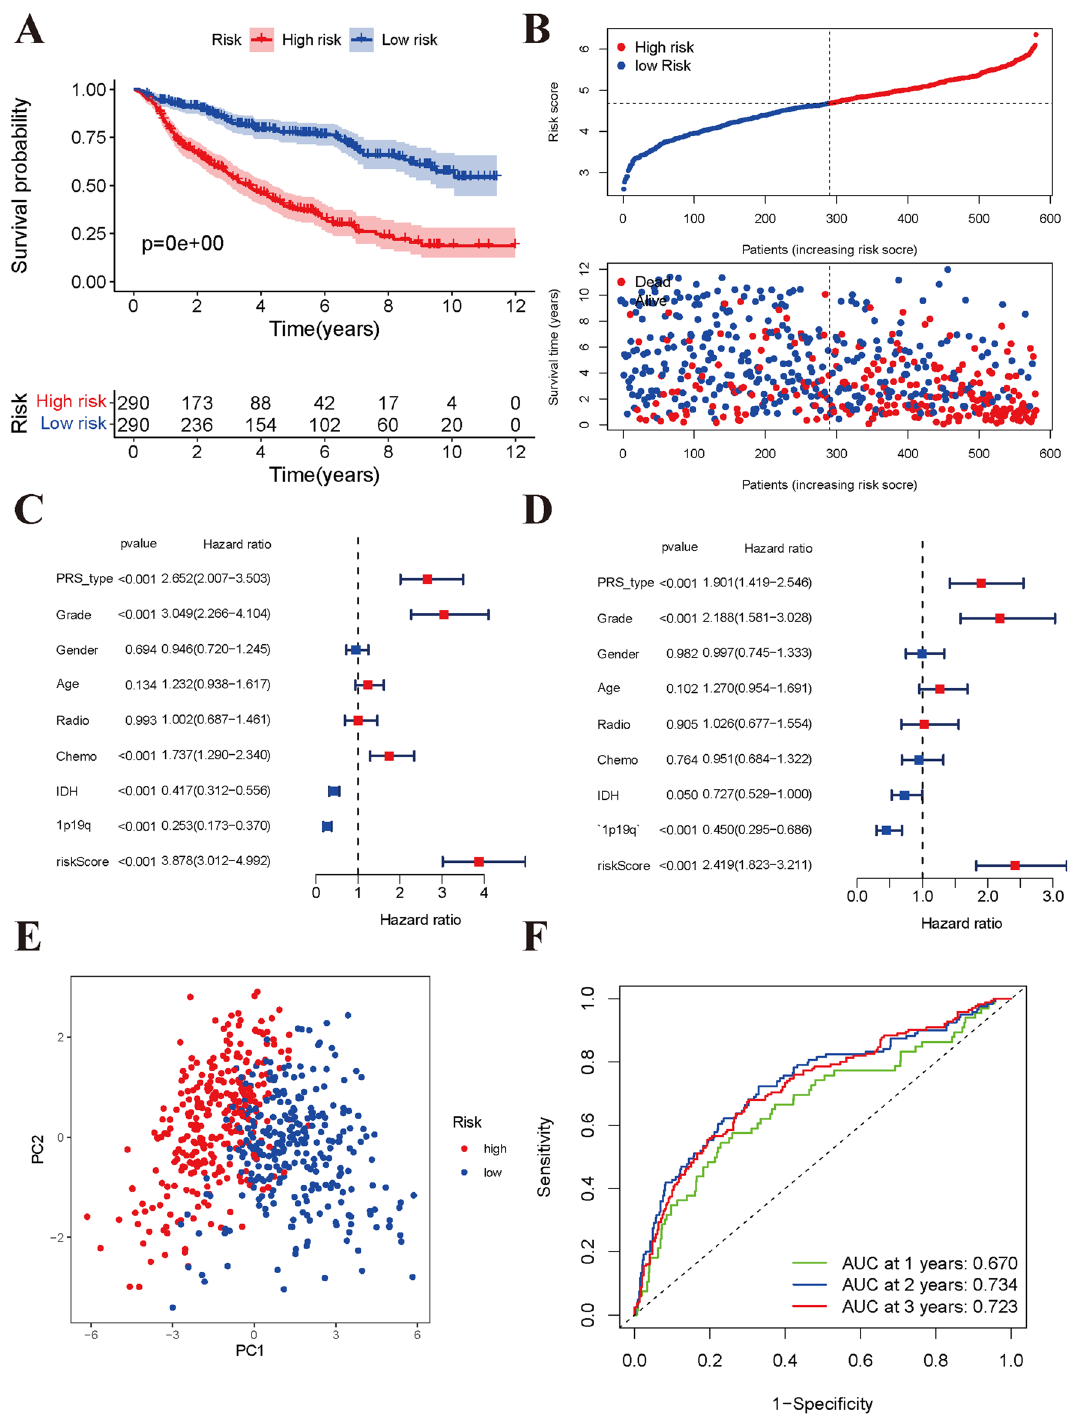
Figure 3. Developing a pyroptosis genes signature can predict overall survival in CGGA cohort. ( A ) Kaplan– Meier survival curves of high- and low-risk groups divided by risk score. ( B ) Distributions of risk score and survival time in different risk groups. ( C ) Univariate cox analysis identified the correlation of risk score and overall survival in low-grade glioma. ( D ) Multivariate cox analysis identified the correlation of risk score and overall survival in low-grade glioma. ( E ) Principal component analysis showed two markedly distributions for high- and low-risk groups. ( F ) The predict ability of risk score for 1-year, 2-year, and 3-year overall